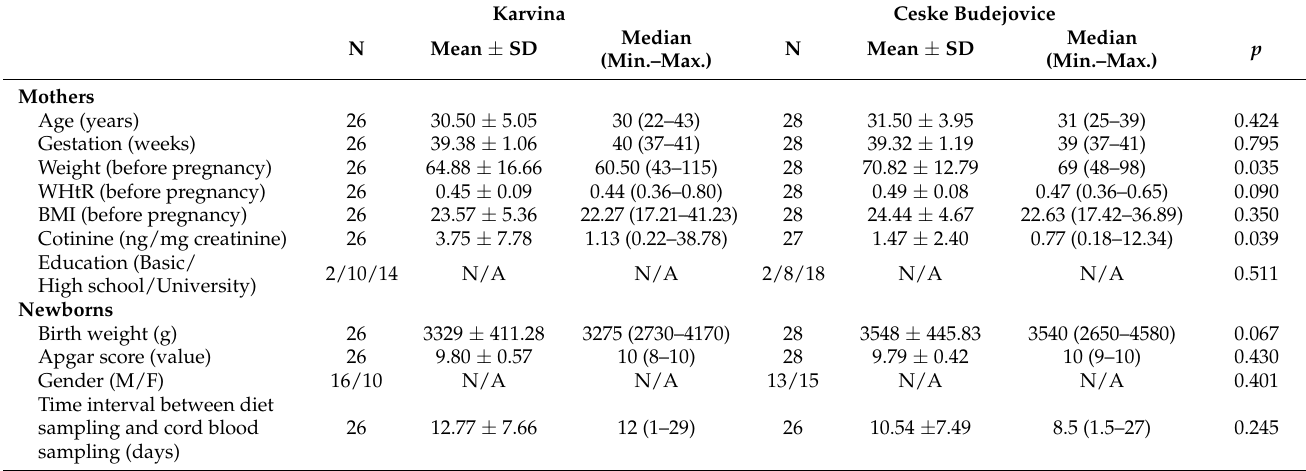
Table 2. Characteristics of the mothers and their newborns from both localities. Karvina Ceske